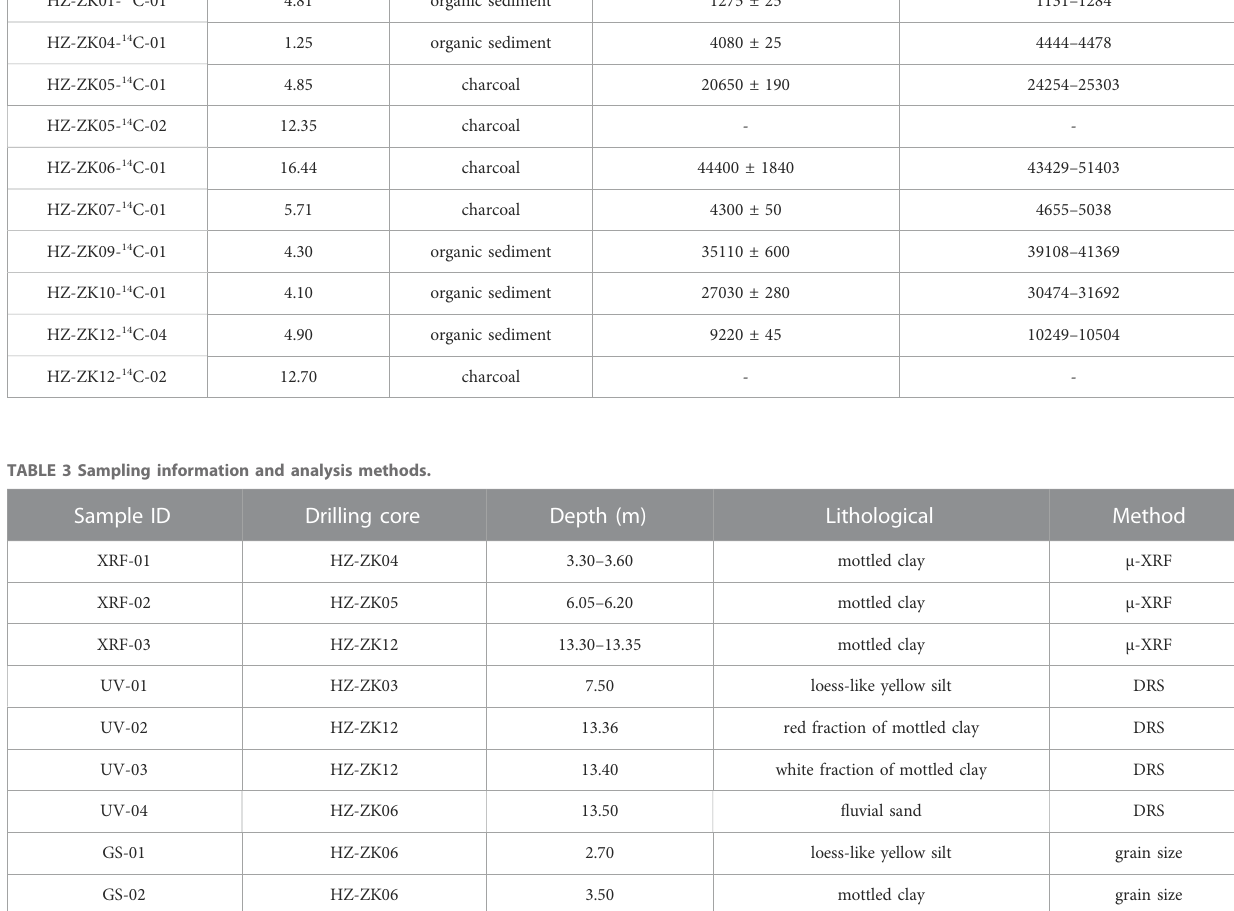
TABLE 2 AMS 14 C dating results of the late Pleistocene sediments in the Huizhou Basin. Sample no.